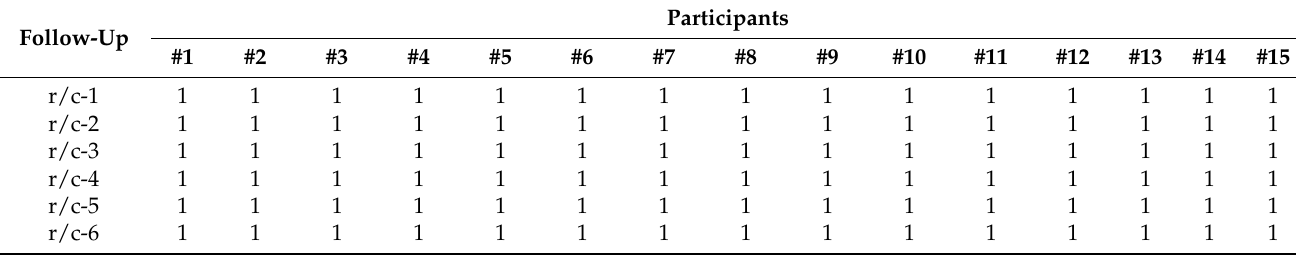
Table 6. Scores according to the FDI criteria for biological properties during 6-month follow-up evaluation.